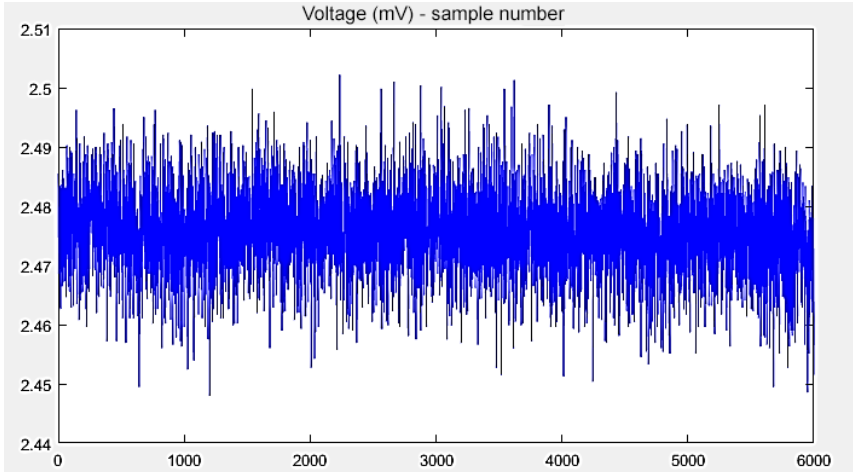
Figure 8. Equivalent input noise waveform of the acquisition board.